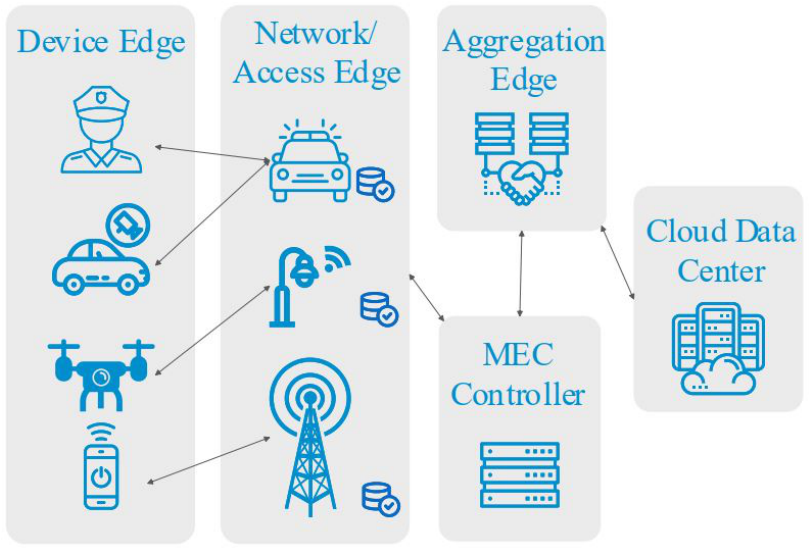
Figure 1. From cloud to network